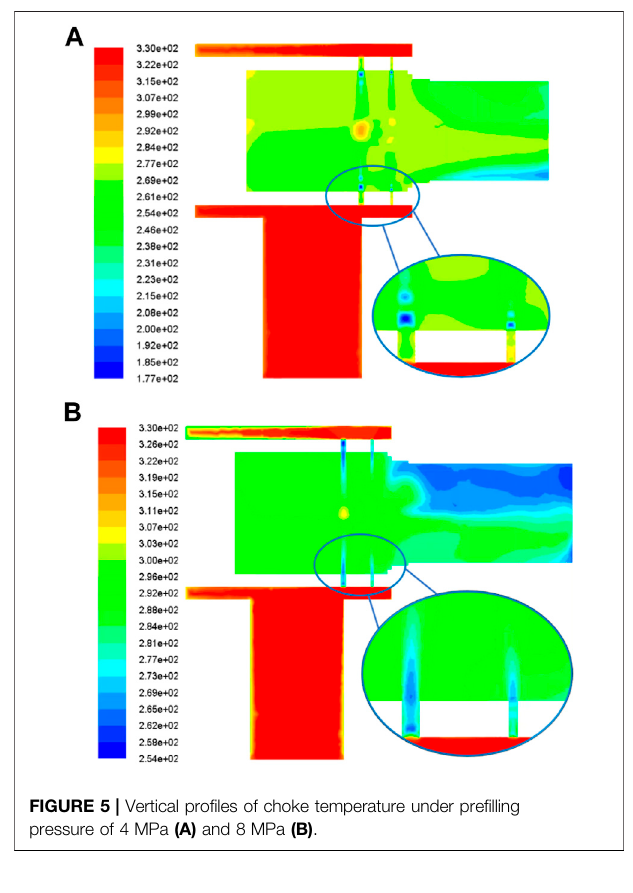
FIGURE 5 | Vertical pro fi les of choke temperature under pre fi lling pressure of 4 MPa (A) and 8 MPa (B) .